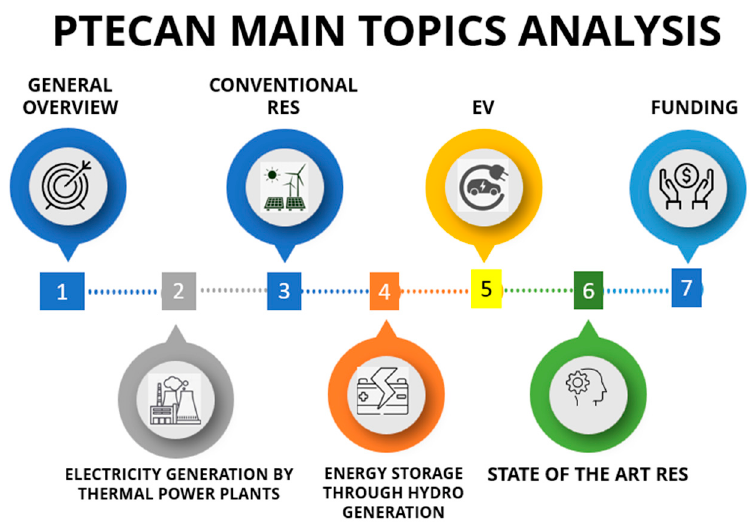
Figure 5. PTECAN main topics analysis structure. Source: Own elaboration.